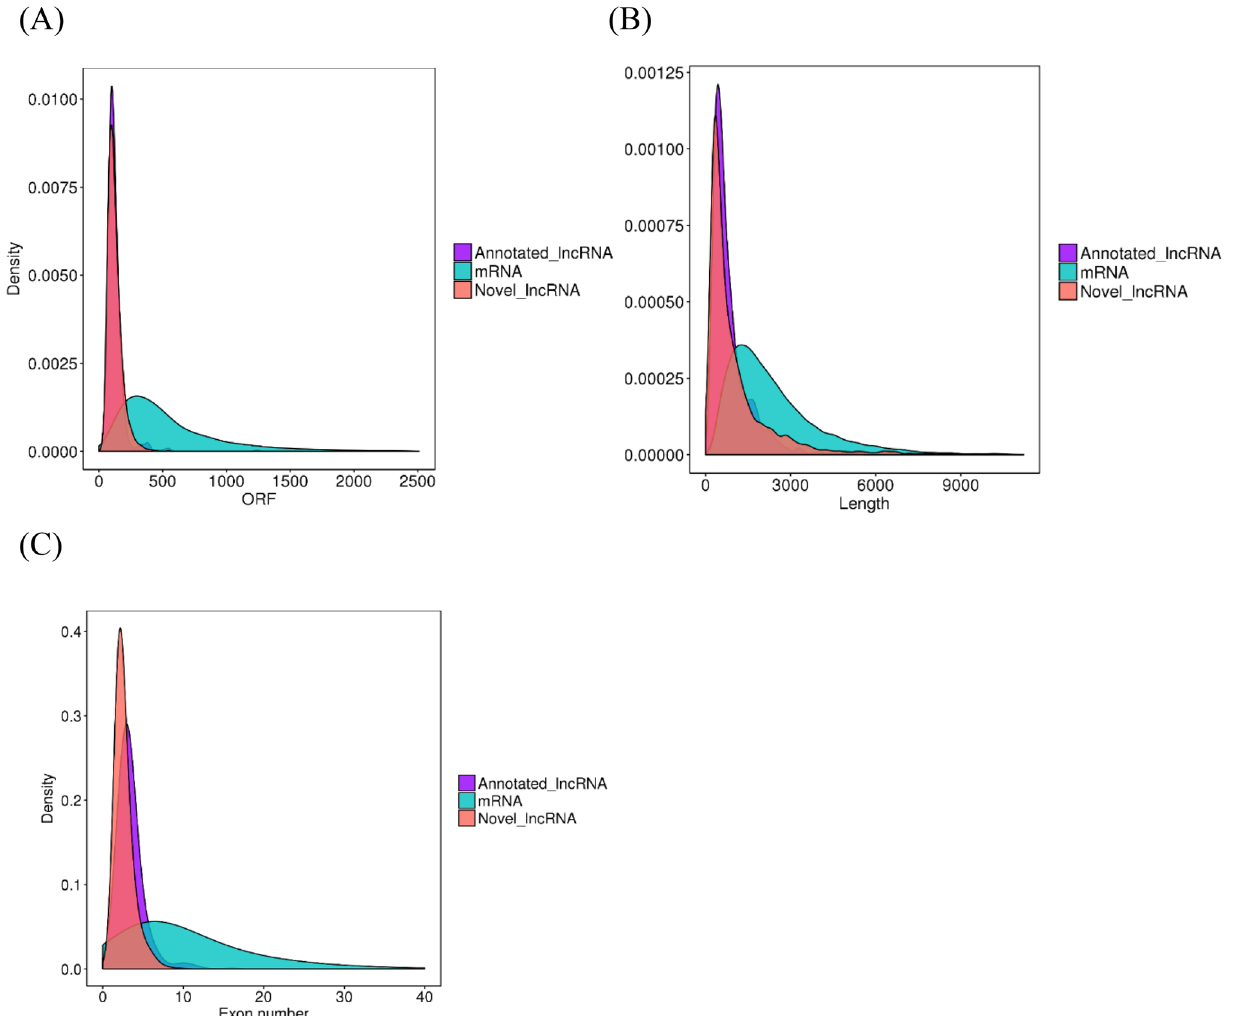
Figure 5. Comparison of features of predicted lncRNAs and mRNAs. ( A ) Expression of lncRNAs and mRNAs. ( B ) Length distribution of predicted lncRNAs and mRNAs. ( C ) Exon number distribution of lncRNAs and